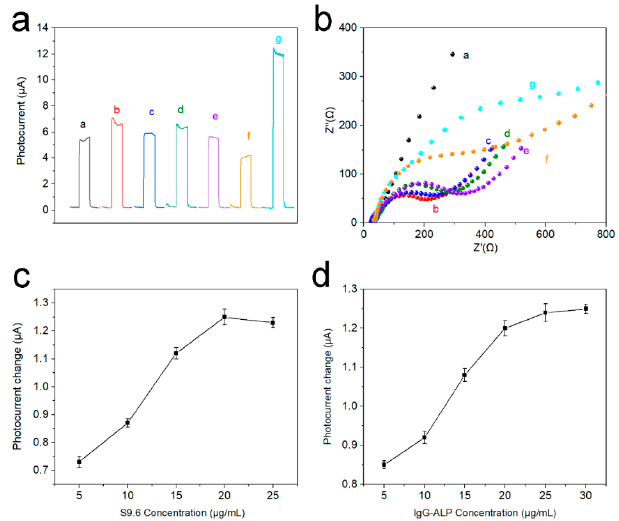
Figure 6. ( a ) Photocurrent response in detection buffer and ( b ) EIS plot in 5.0 mM Fe(CN) 6 3 − /4 − solu- tion of different electrodes: curve a, Ti 3 C 2 T x QDs/(001) TiO 2 /FTO; curve b, after dropping AuNPs; curve c, after probe DNA loading; curve d, after incubation with MCH; curve e, after incubation with 1 nM microRNA-155; curve f, after incubation with antibody; curve g, incubation with IgG- ALP, ( c ) the change of the response current with different concentrations of S9.6 and ( d ) the change of the response current with different concentrations of IgG-ALP.